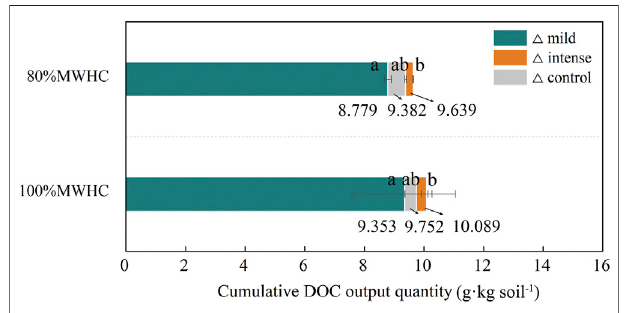
FIGURE 5 | Cumulative DOC output quantity. Mild means freeze – thaw cycle at − 5~4 ° C; intense means freeze – thaw cycle at − 15 – 4 ° C. Triangles ( △ ) indicate the difference of cumulative DOC output quantity between the target setting condition and next sequence setting condition.